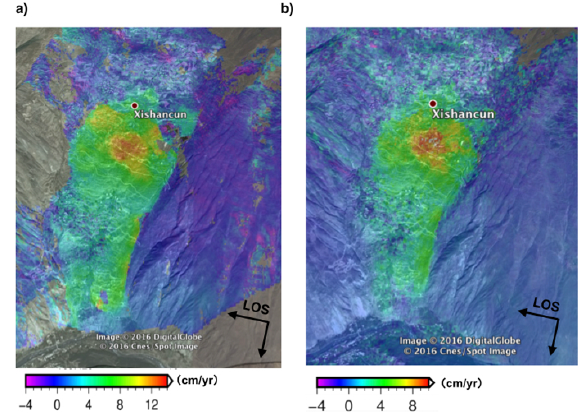
Figure 4. Deformation displacement rate maps derived from TerraSAR-X (a) and Sentinel-1 (b) datasets Disparities between TerraSAR-X and Sentinel-1 time series results could be caused by: 1) Limited time span for TerraSAR-X results in its overestimate of annual velocity. 2) Different temporal samplings. 3) Different observation geometries. 4) DEM-induced uncertainties.